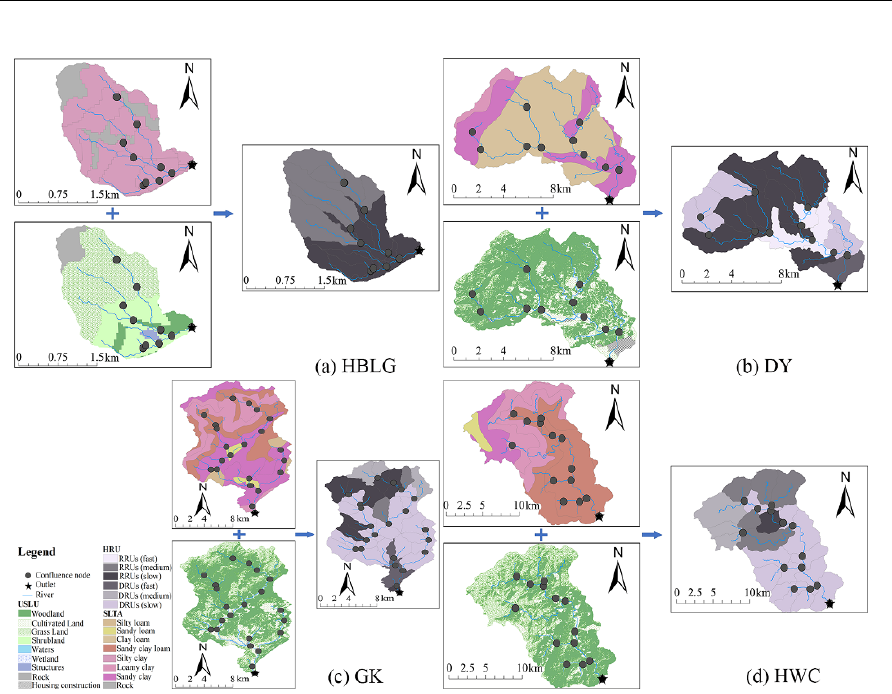
Figure 4. Generations of hydrological response units (HRUs).